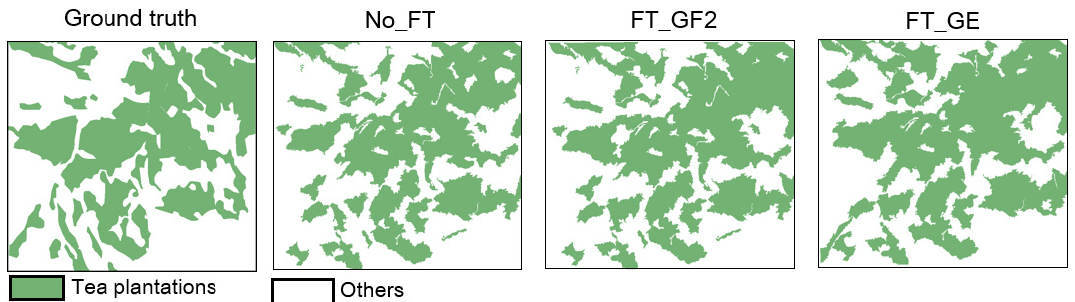
Figure 9. Tea plantation results on GF-2 images by the No_FT, FT_GF2, and FT_GE